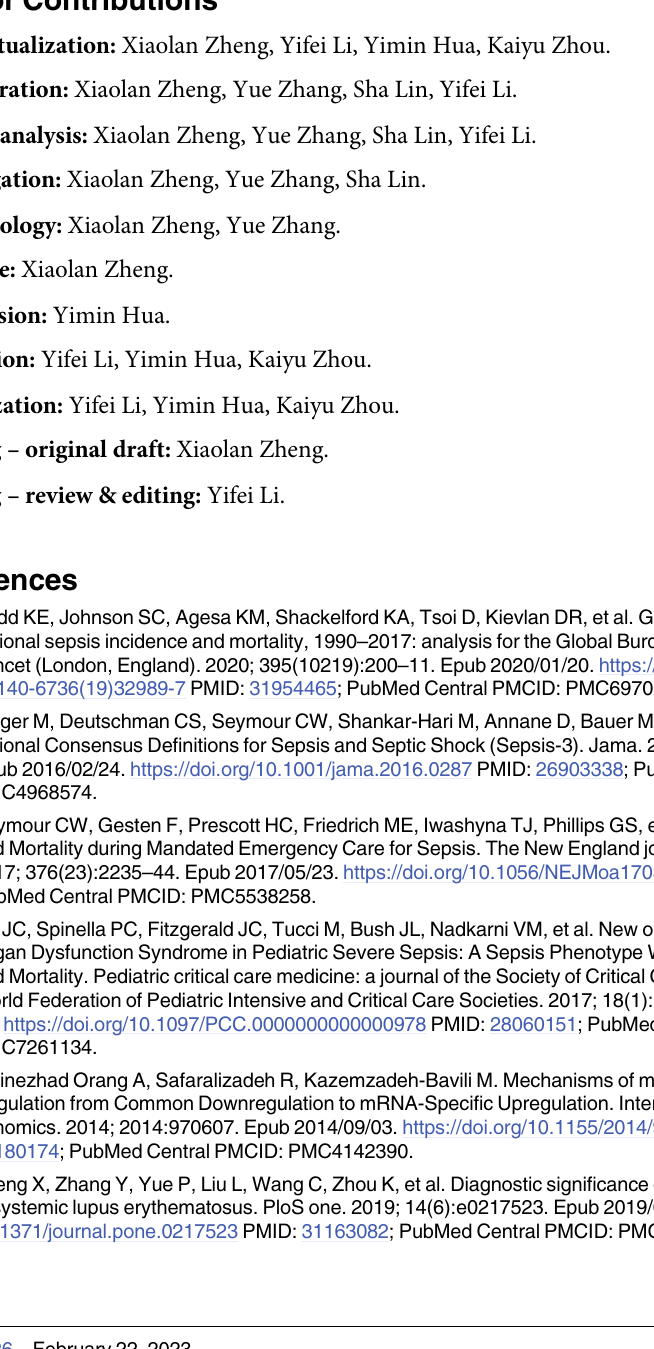
S5 Fig. Performance of miR-125a detection for sepsis diagnosis. (A) Pooled sensitivity. (B) Pooled specificity. (C) Overall DOR. (D) The SROCs for all datasets. (PDF) S6 Fig. TSA plot of miRNAs for sepsis diagnosis. (A) TSA plot of TmiR for sepsis diagnosis. (B) TSA plot of miR-155-5p for sepsis diagnosis. (C) TSA plot of miR-21 for sepsis diagnosis. (D) TSA plot of miR-223-3p for sepsis diagnosis. (E) TSA plot of miR-146a for sepsis diagno- sis. (F) TSA plot of miR-125a for sepsis diagnosis.